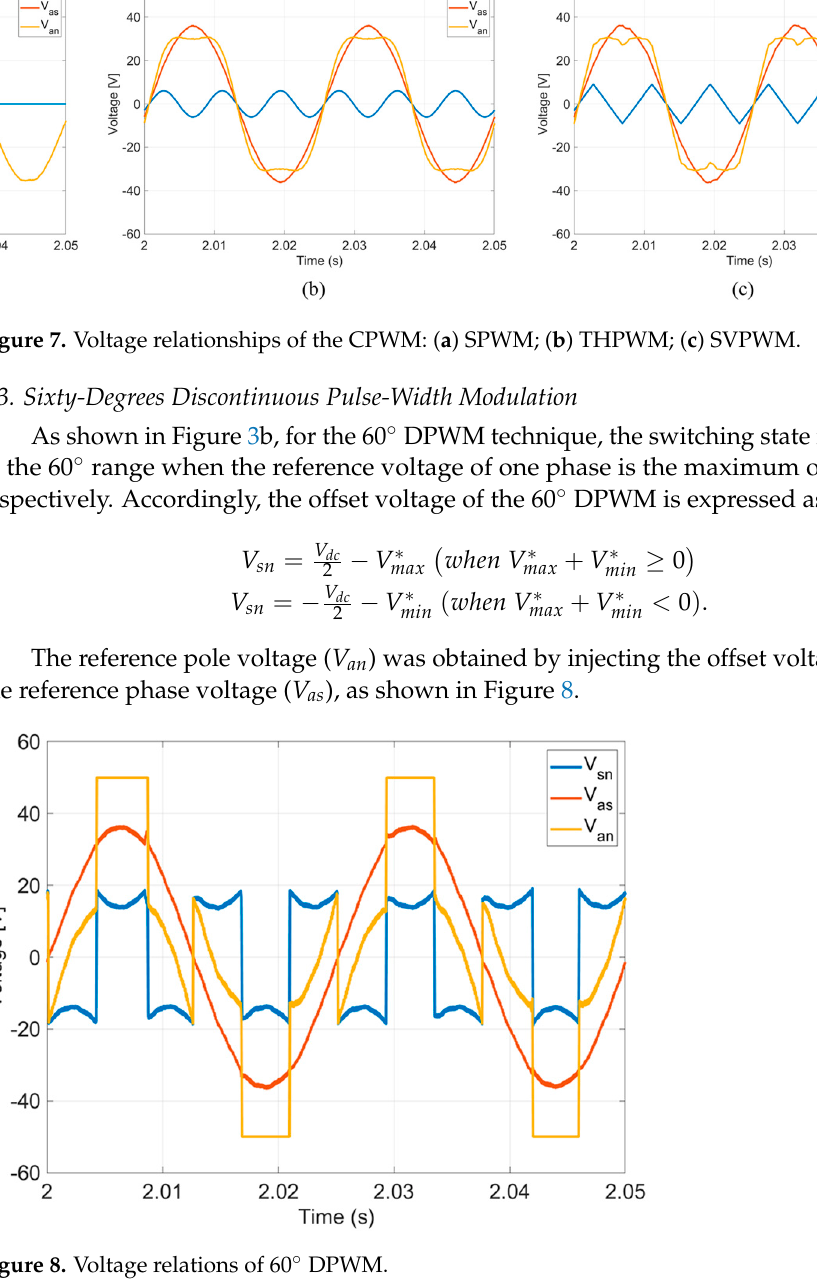
Figure 6. Technique for symmetric SVPWM.